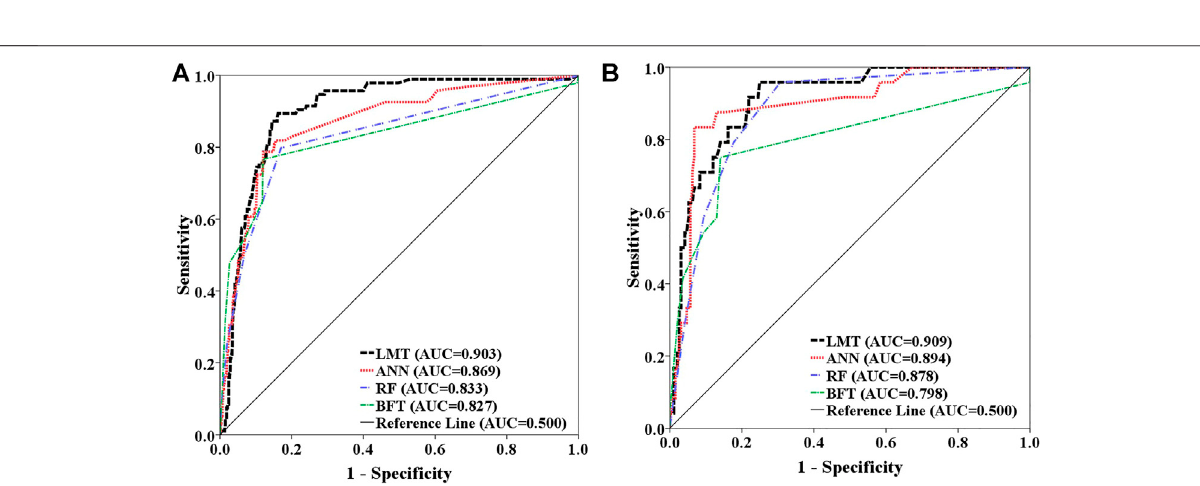
Frontiers in Environmental Science |